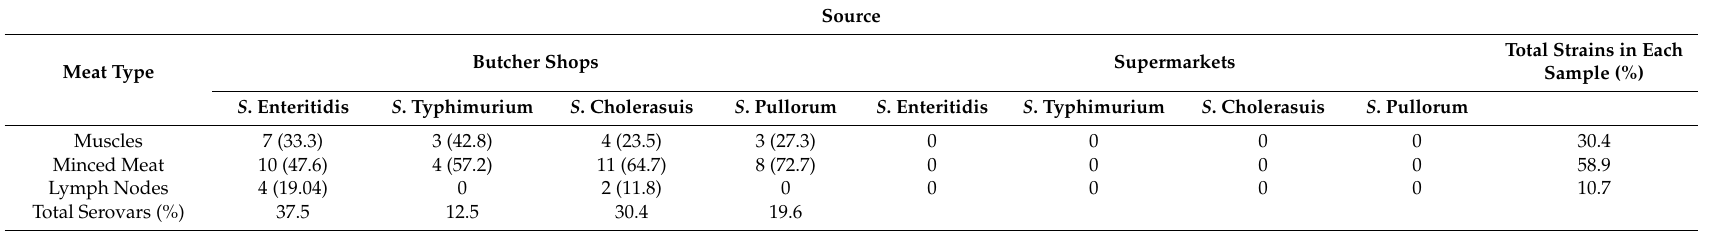
Table 2. Prevalence of S . Enteritidis, S . Typhimurium, S . Cholerasuis and S . Pullorum in di ff erent beef